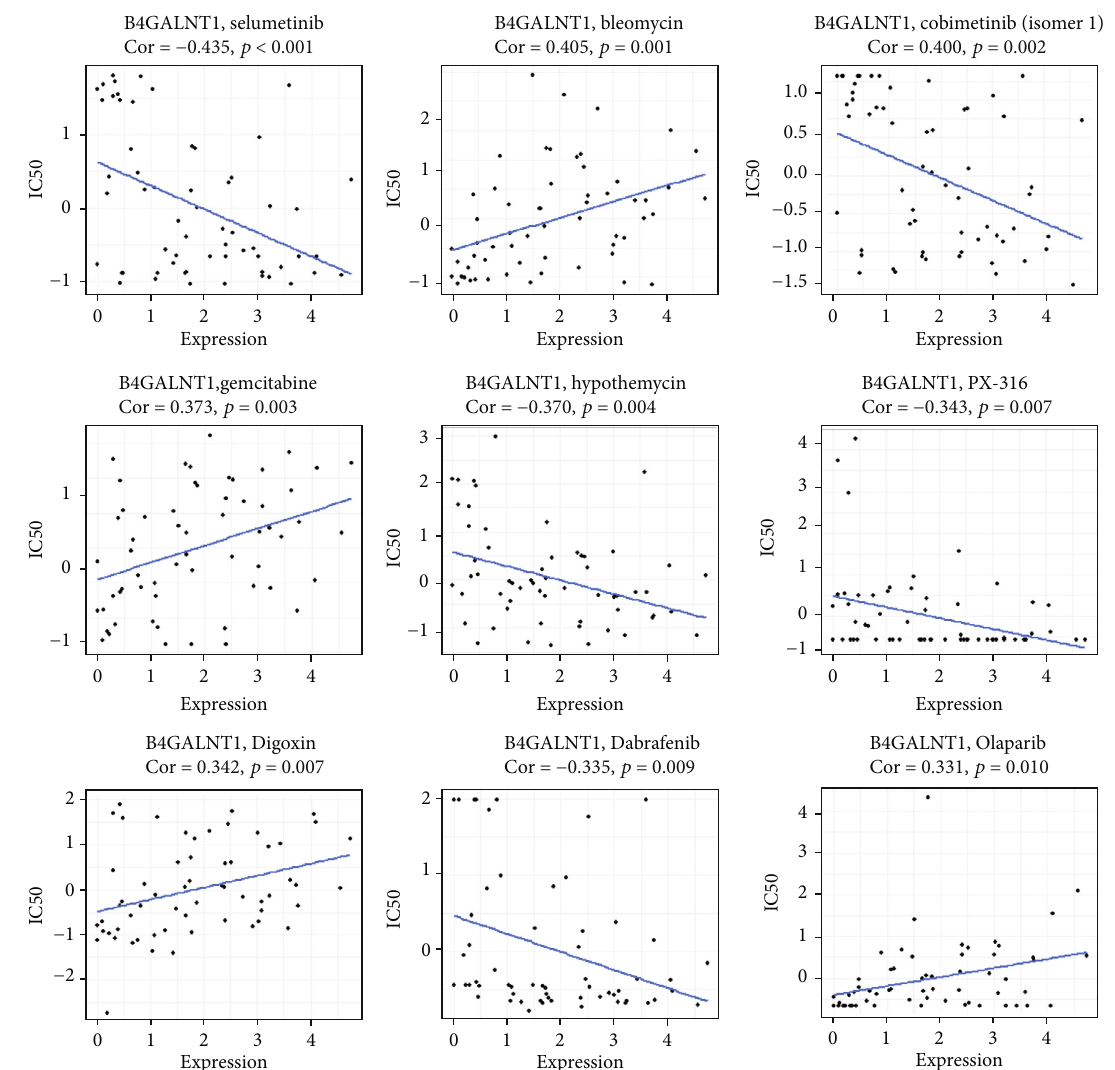
Figure 13: Top 9 correlations between B4GALNT1 and drug